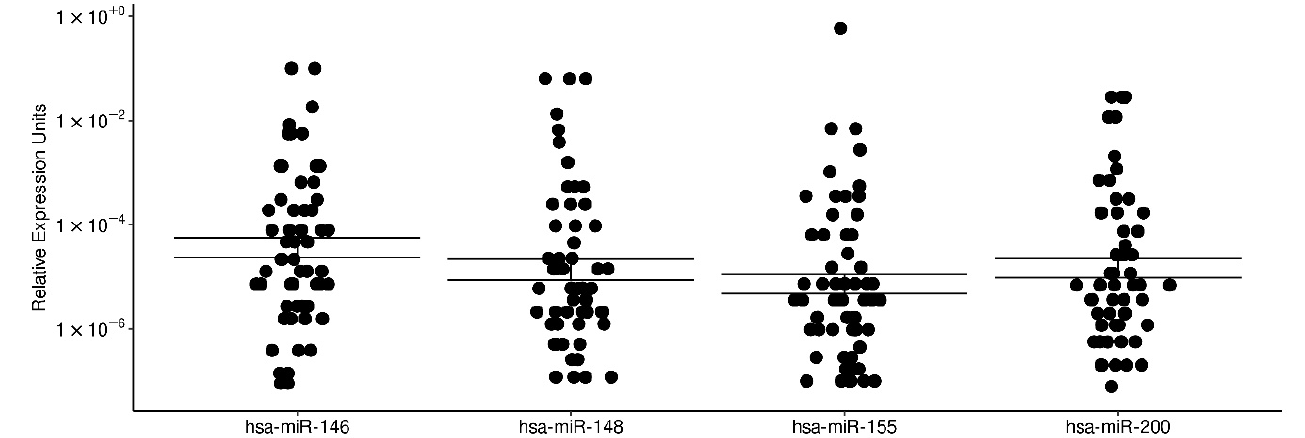
Figure 1. Expression of selected miRNAs in human colostrum/milk. hsa-miR146 (miR-146b-5p); hsa-miR-148 (miR148a-3p), hsa-miR-155 (miR155-5p), hsa-miR-200 (mir200a-3p). The Y-axis shows the relative expression of each miRNA with respect to the internal control cel-miR-39, and the X-axis shows the corresponding miRNA. Each dot in the plot represents a sample. The double horizontal lines indicate the standard error of the mean. One-way ANOVA statistical test shows no significant differences in miRNA levels, Pr(>F) = 0.7136.